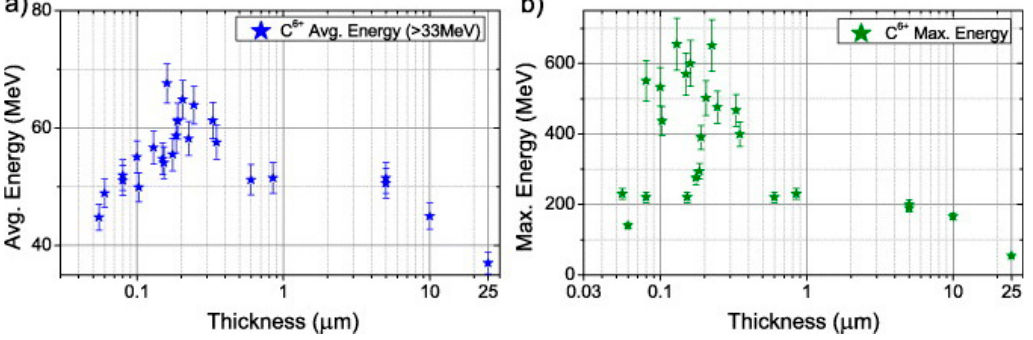
Figure 7. The measured average and maximum particle energy C 6+ ions in the “Break-Out Afterburner” (BOA) and TNSA acceleration regimes is shown as a function of target thickness. In the BOA regime ~30 nm the particles have a factor of 5 higher energy. Reproduced from Jung et al .